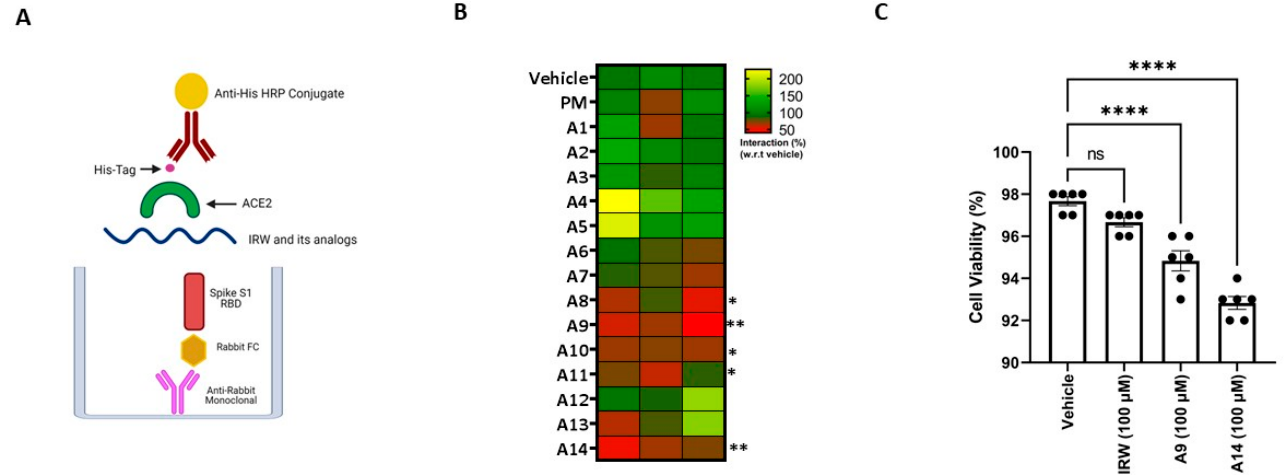
Figure 2. Impact of IRW and its analogs on SARS-CoV-2 S1 RBD-ACE2 interaction. ( A ) An in vitro assay was conducted to assess the possible ( B ) inhibitory impact of IRW and its analog peptides (50 µM) on SARS-CoV-2 S1 RBD-ACE2 interaction and ( C ) toxicity analysis of the selected peptides. The results are expressed as percentage inhibition with respect vehicle control (nuclease free water). Data expressed as mean ± SEM of n = 3–6. Experiments were reproduced three times with independent tips and samples. p values were determined by Analysis by one-way ANOVA followed by Bonferroni’s post hoc test for the vehicle. * p < 0.05, ** p < 0.01, **** p < 0.001 versus vehicle and ns: nonsignificant.